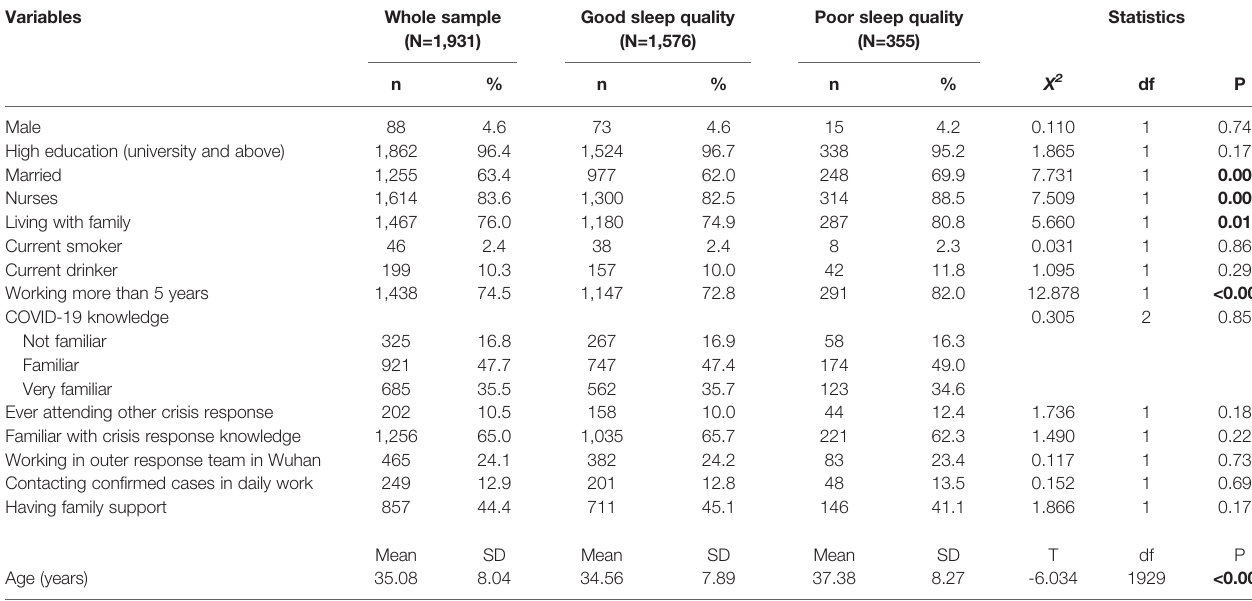
TABLE 1 | Demographic characteristics of the study sample (N=1,931). Variables Whole sample